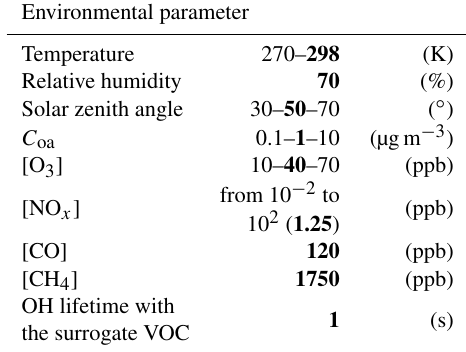
Table 1. Constant environmental conditions used in the various sce- narios. For each scenario, the concentrations of OH, HO 2 , NO and NO 2 are at the stationary state induced by the constant conditions. Values in bold represent the conditions used in the reference sce- nario.